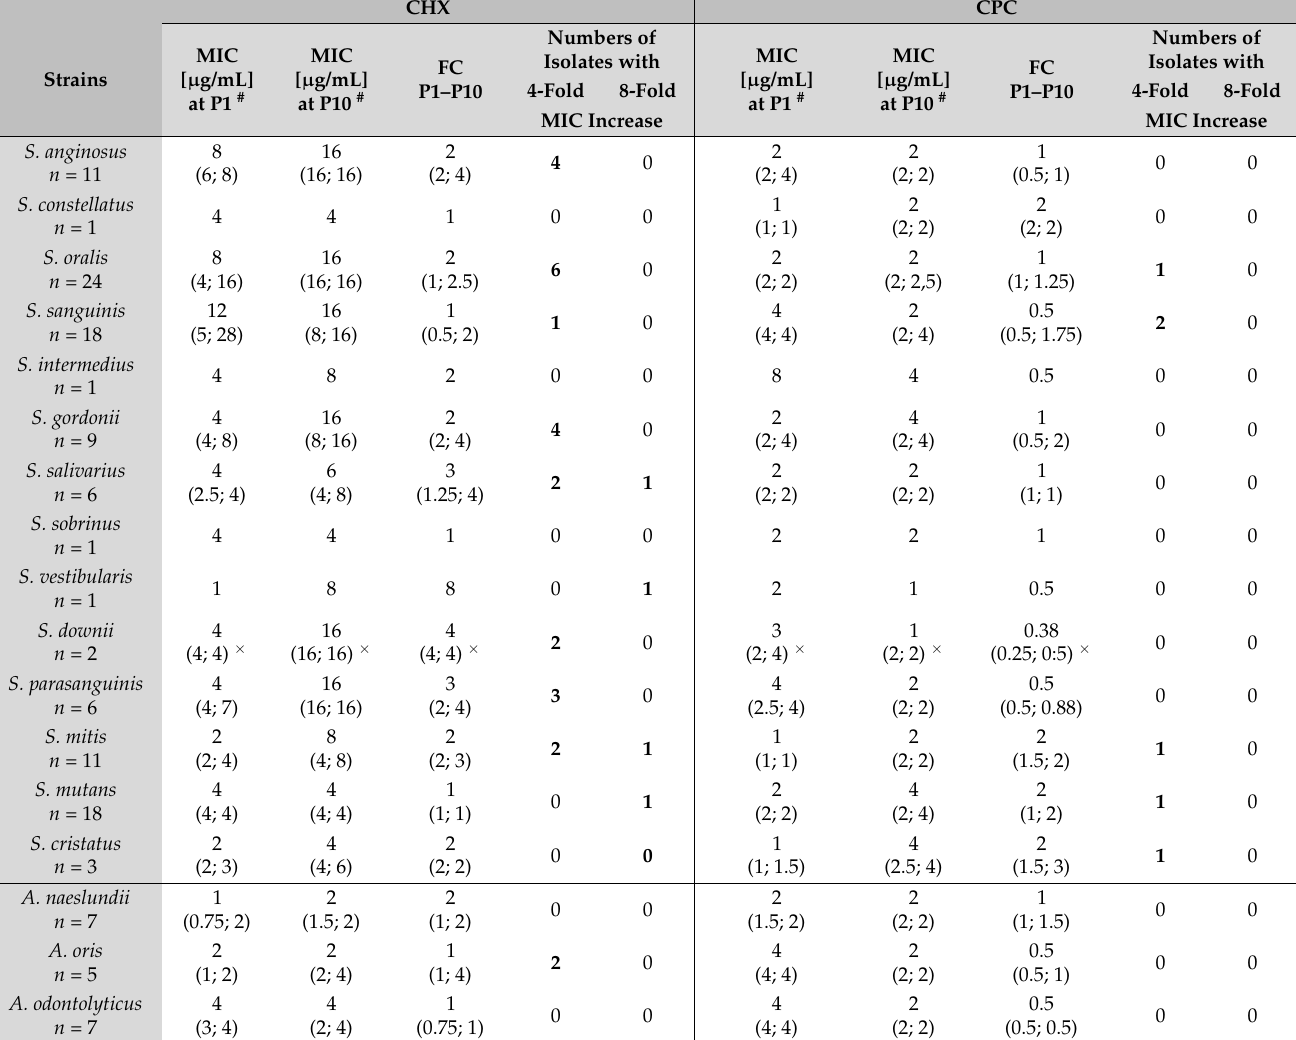
Numbers of Isolates with